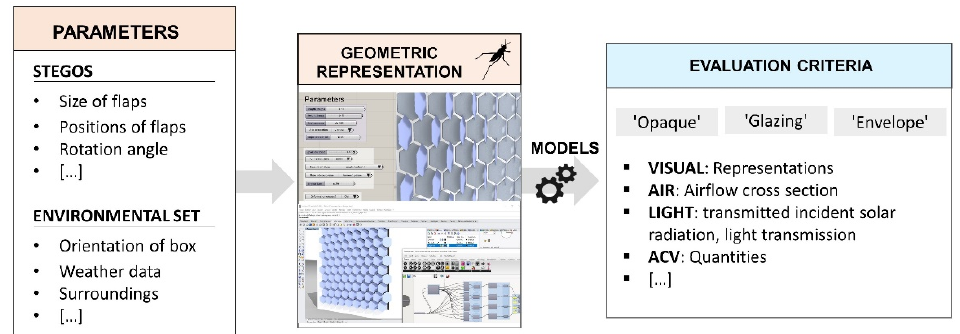
Figure 13. Steps followed during the geometric modeling of the Stegos design implemented in the test box: (from left to right) definitions of parameters, implementation in Rhinoceros Grasshopper, use of embedded models, and evaluation according to various criteria.